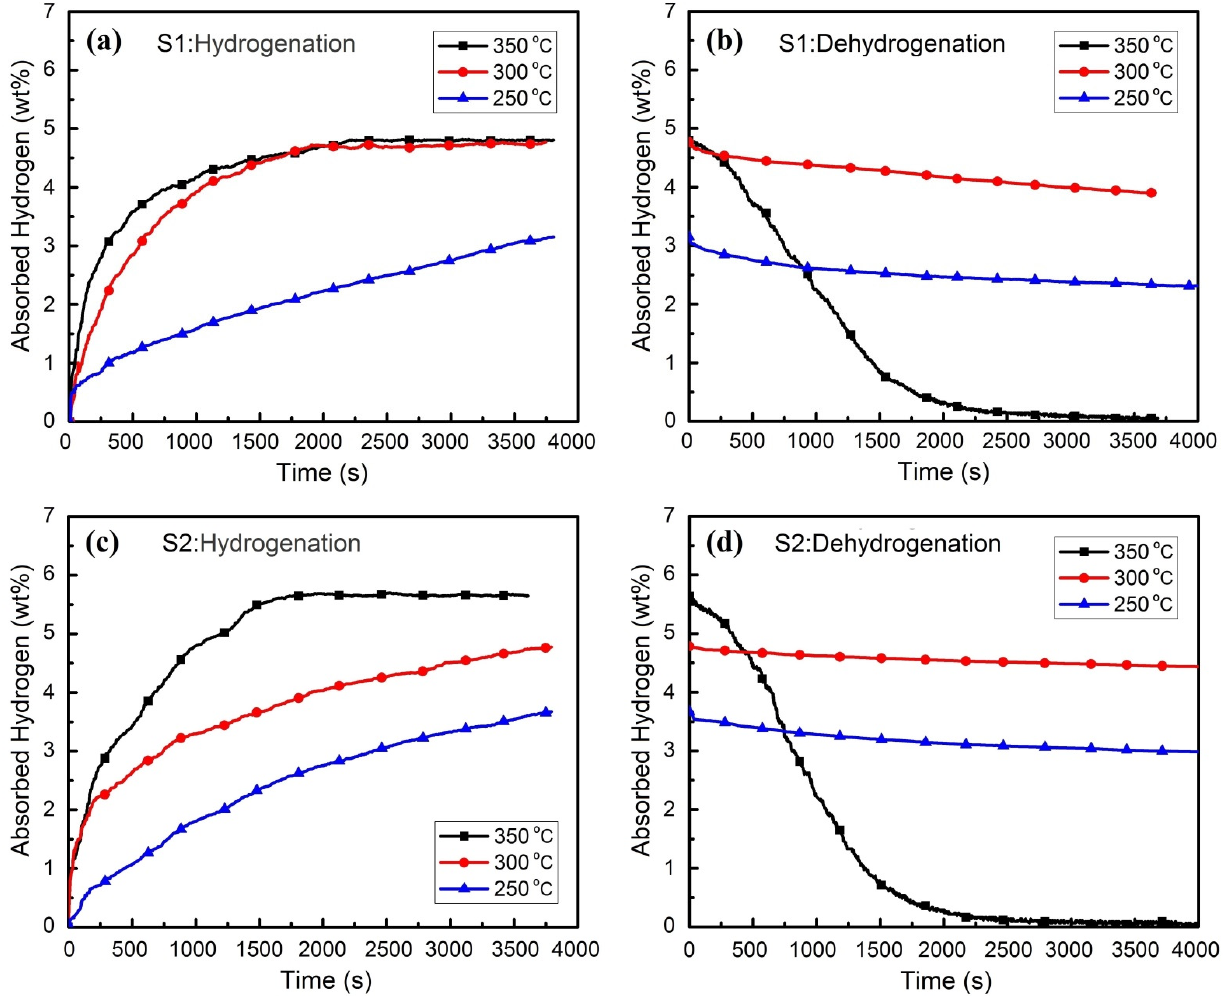
Figure 2. Hydrogenation kinetics at 30 bar and dehydrogenation kinetics at 10 -1 mbar for different temperatures. ( a , b ) S1 sample (a pass of TPCAE at 340 °C), ( c , d ) S2 sample (second pass of TPCAE at 300 °C).